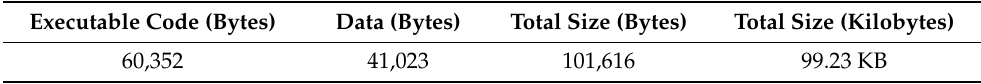
Table 1. Our embedded software code size breakdown.